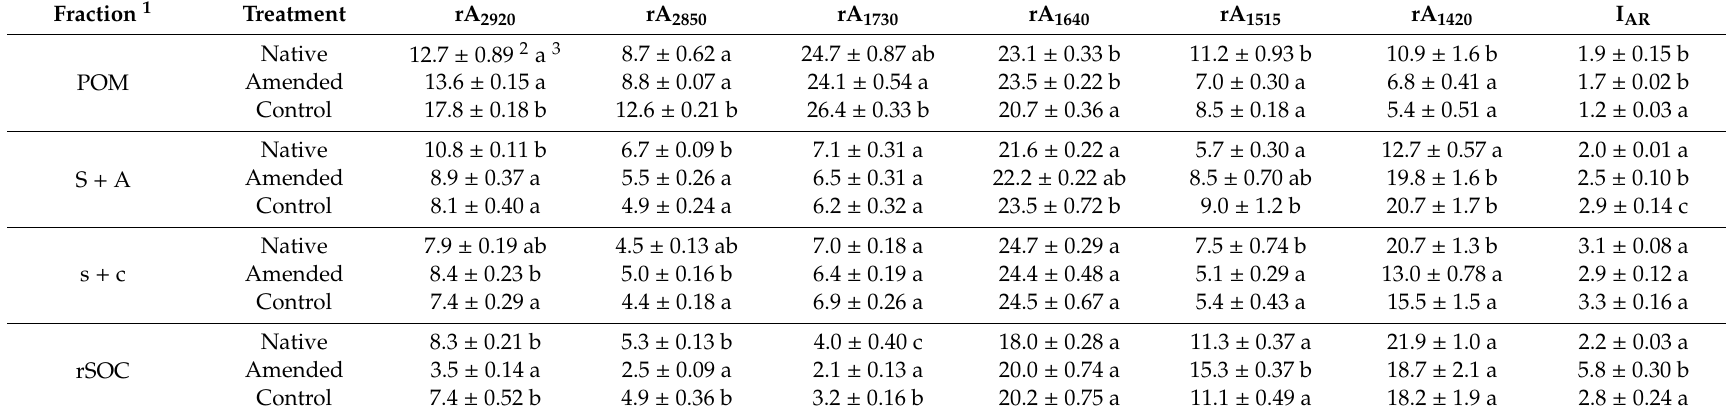
Table 2. Relative absorbance as a % of the sum of all selected peak heights, and aromaticity index (I AR ) derived from the FT-IR spectra of the soil fractions in the Luvisol